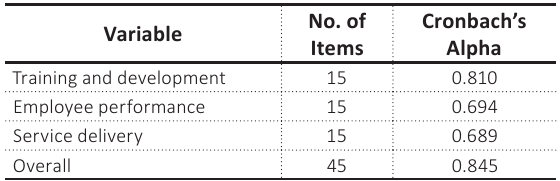
Table 2. Questionnaire reliability scores